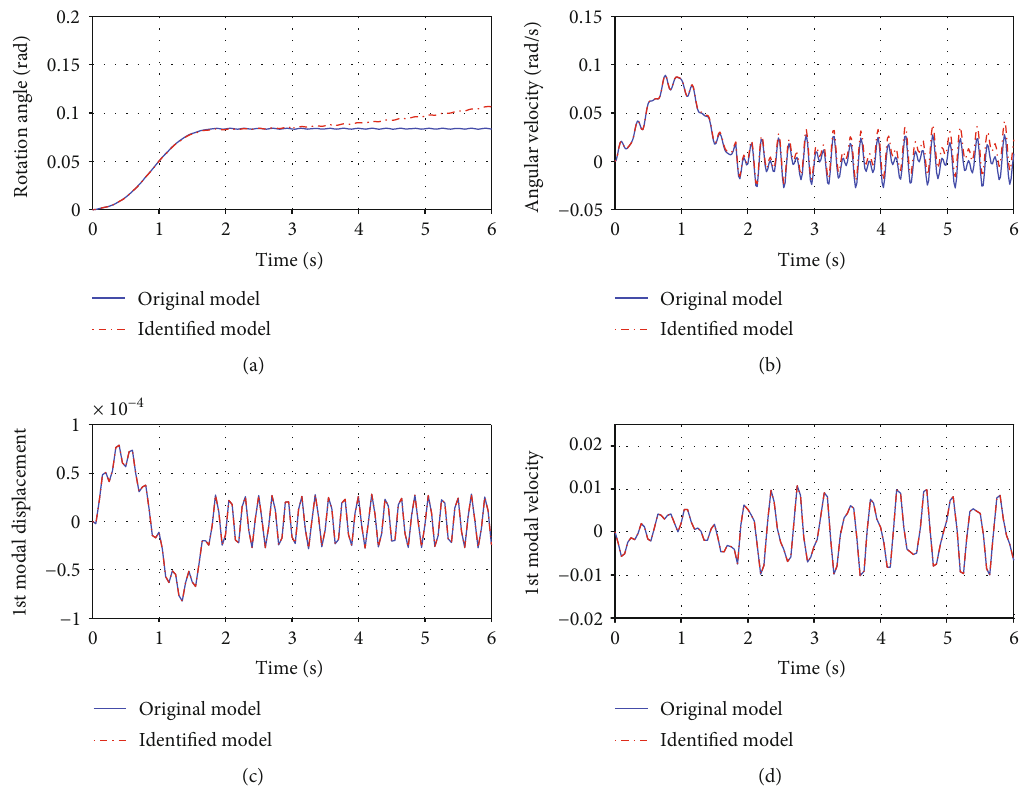
Figure 8: Test response signals of rotation angle δθ , angular velocity δ _ θ , 1st modal displacement δη working